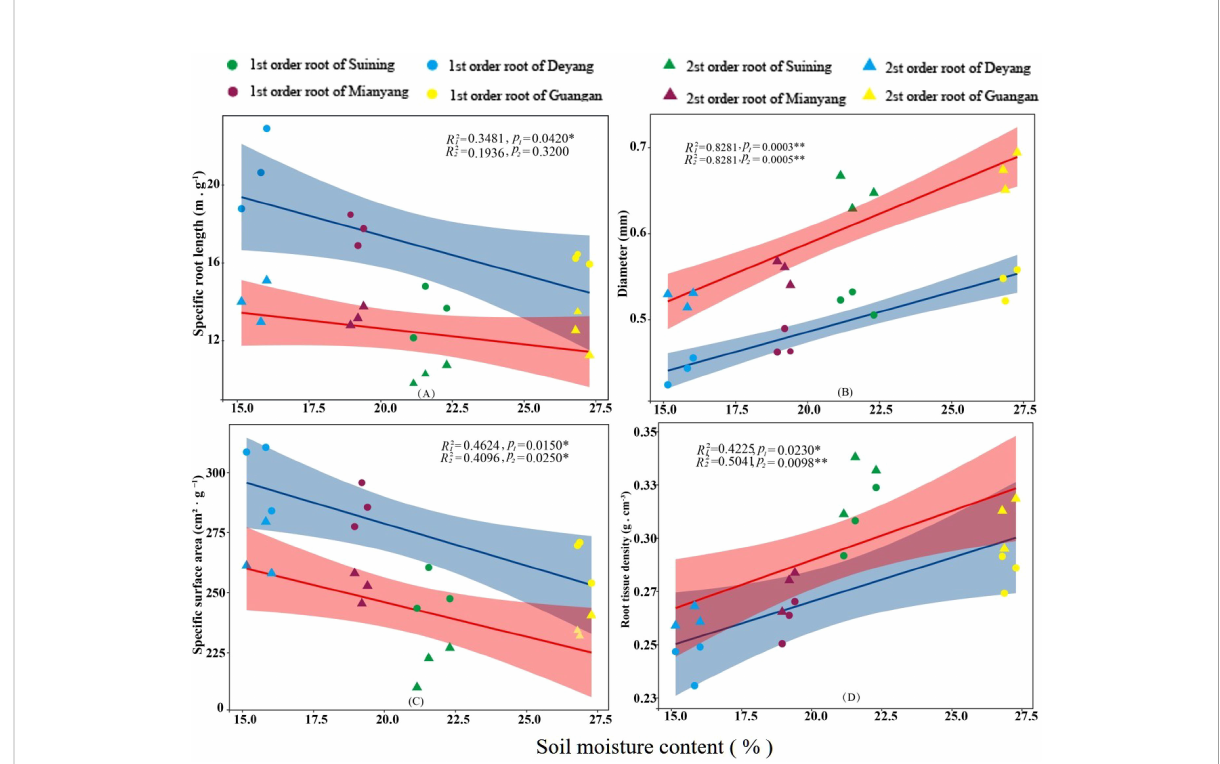
FIGURE 6 Effects of soil moisture on speci fi c root length, root diameter, speci fi c root surface area, and root tissue density at four research sites. R 12 and R 2 2 represent coef fi cients of determination for regressions of fi rst- and second-order fi ne roots * and ** indicate signi fi cance at p < 0.05 and p < 0.01, respectively. p 1 and p 2 are p-values indicating signi fi cance of regressions with fi rst- and second-order fi ne roots, respectively. The shaded part is the con fi dence interval of the fi tting line, regimes (n = 3 per